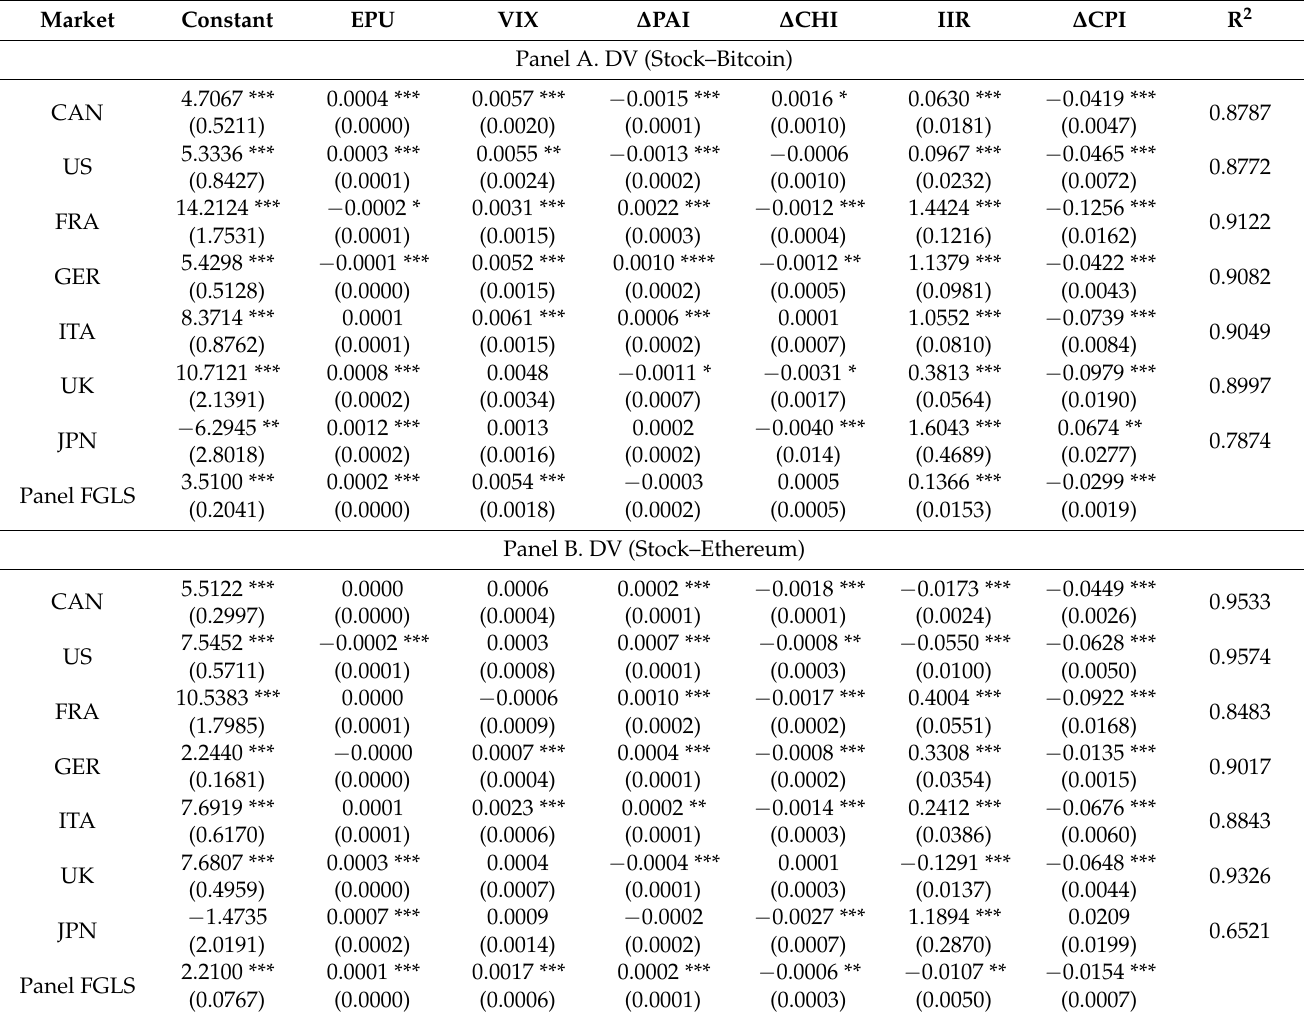
Table 3. SUR on Determinants of Long Investment Horizon Stock-Cryptocurrency